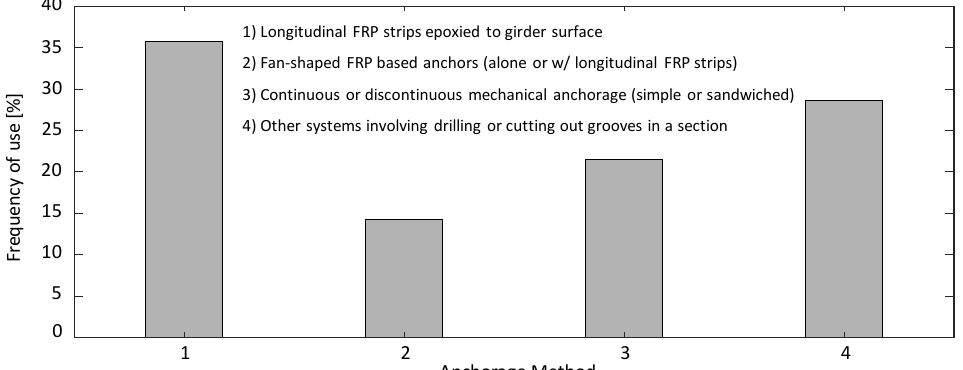
Figure 17. Frequency of use of different anchorage systems found in the literature.